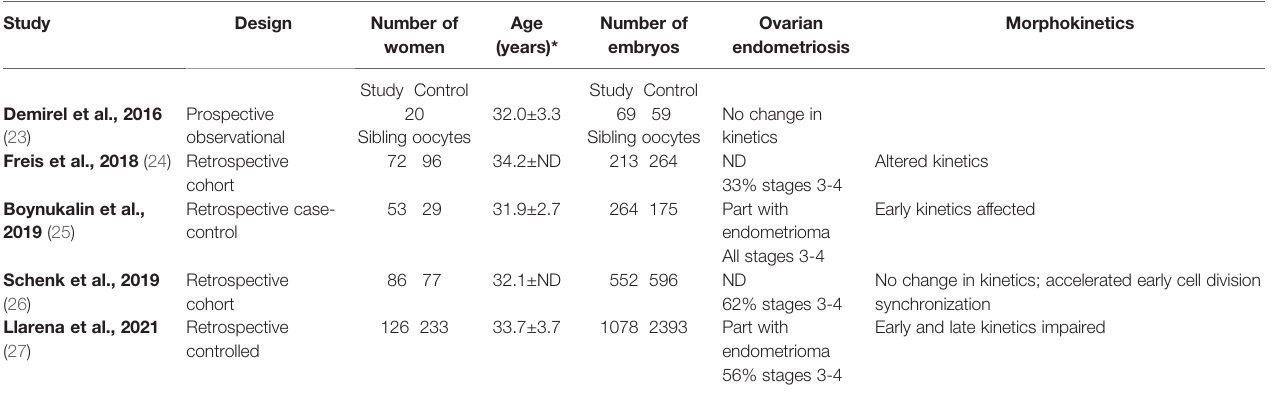
TABLE 2 | Summary of clinical studies evaluating embryos by time-lapse morphokinetics in endometriosis patients as compared to